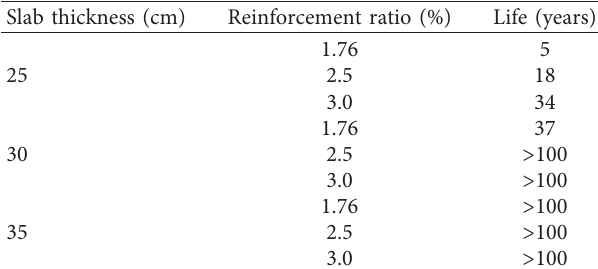
Table 13: Punching fatigue life of the bridge-deck concrete under different slab thicknesses and reinforcement